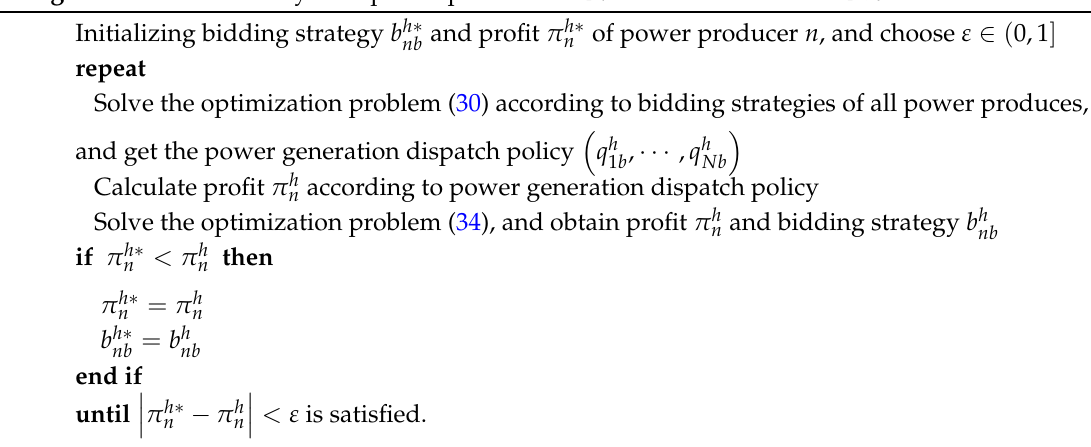
Algorithm 1: Executed by each power producer n ∈ N at each time slot h ∈ H